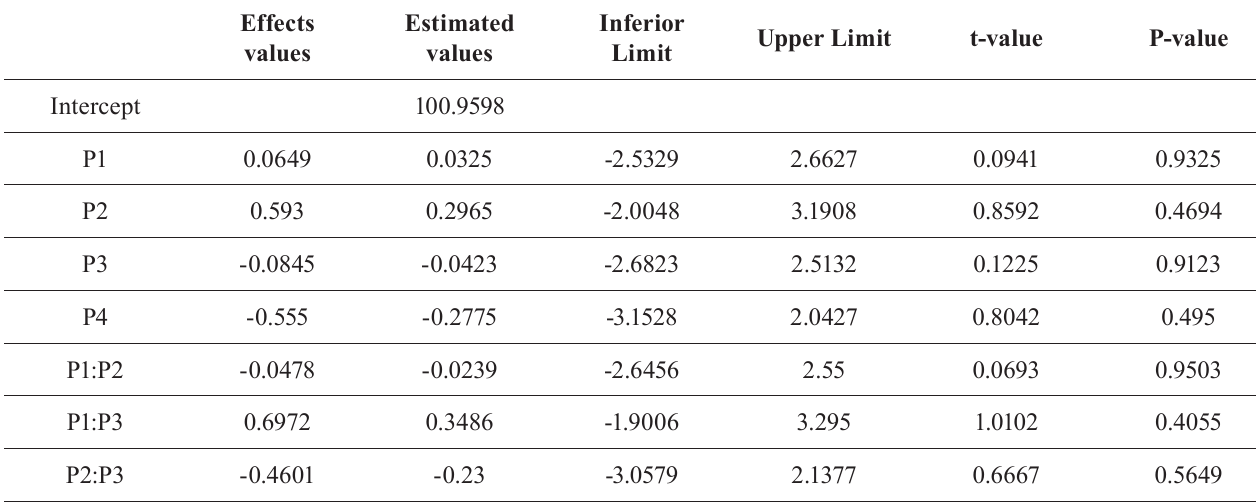
TABLE VIIIC . Values of effects: estimated, limit, and Student’s t-test for EHMC